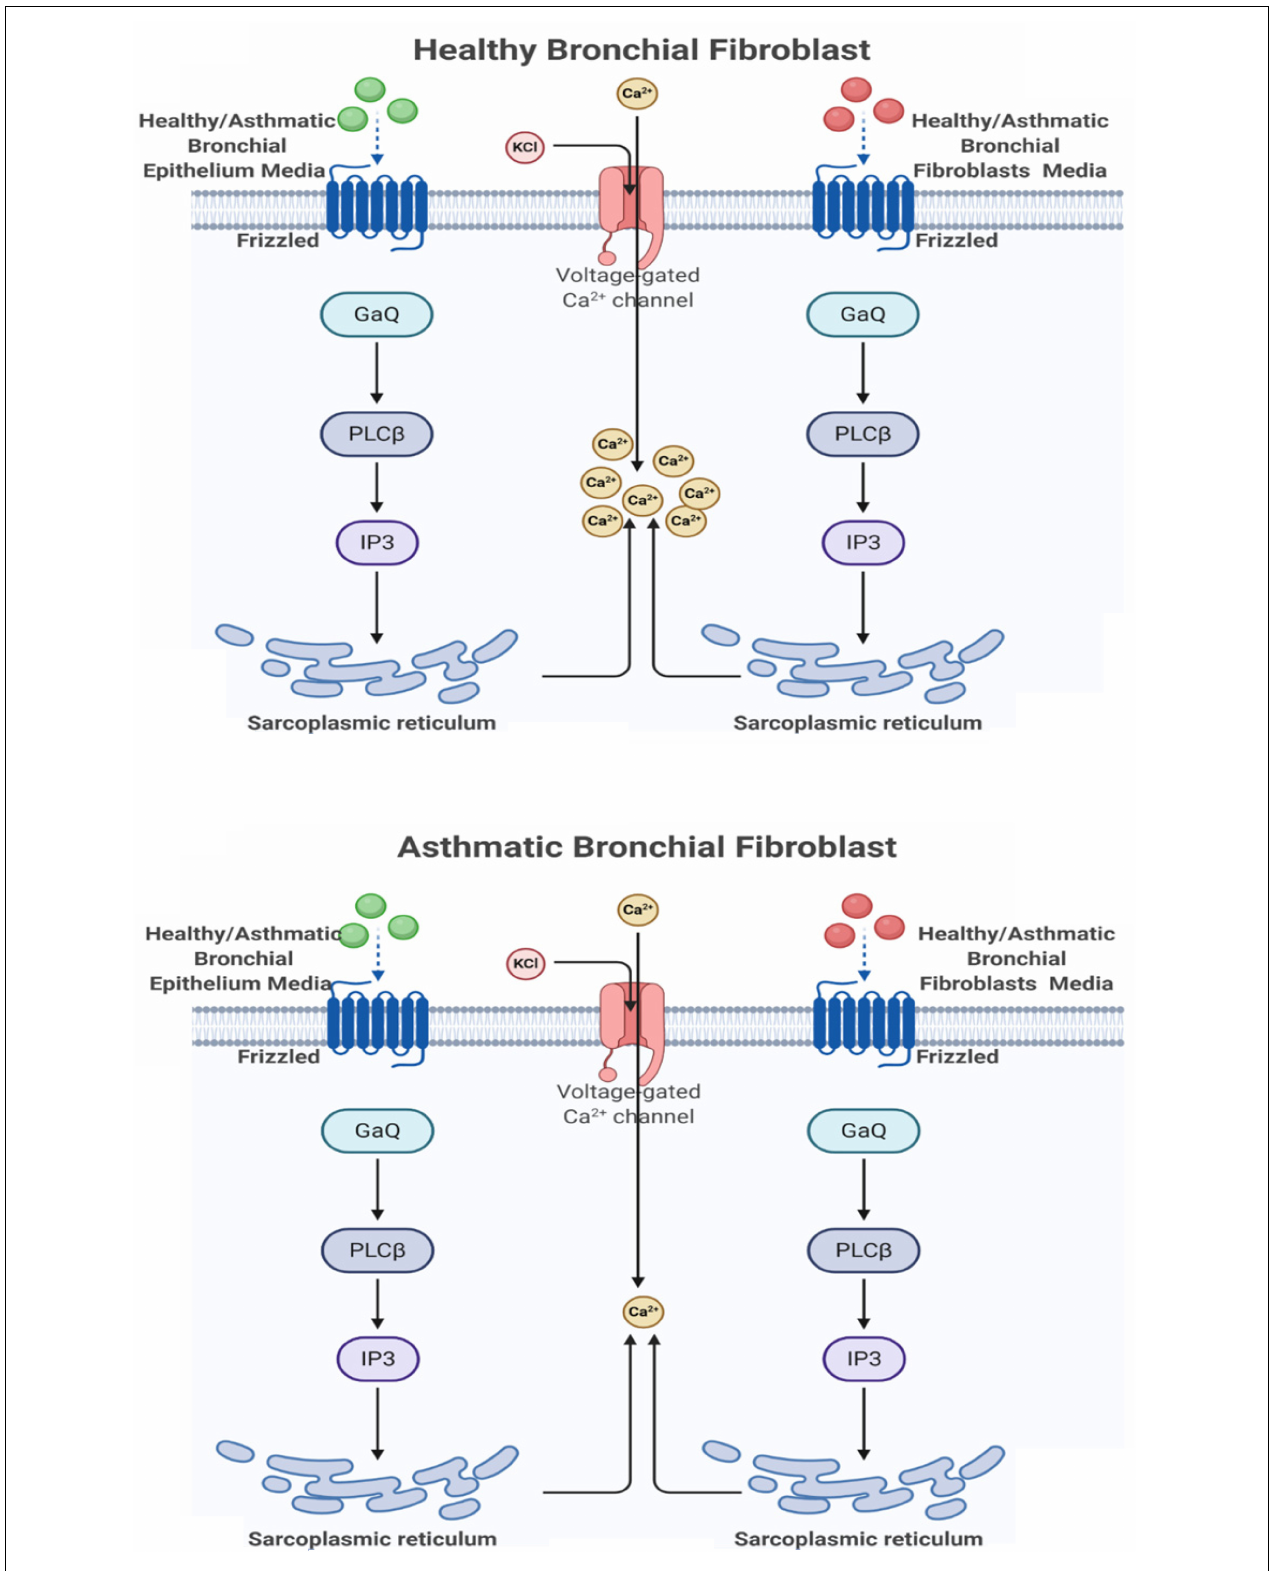
FIGURE 15 | Schematic representation of the effect of healthy and asthmatic bronchial epithelium and fibroblasts supernatant on Ca2+ mobilization in healthy fibroblasts and fibroblasts from asthmatic patients. Created with Biorender.com.